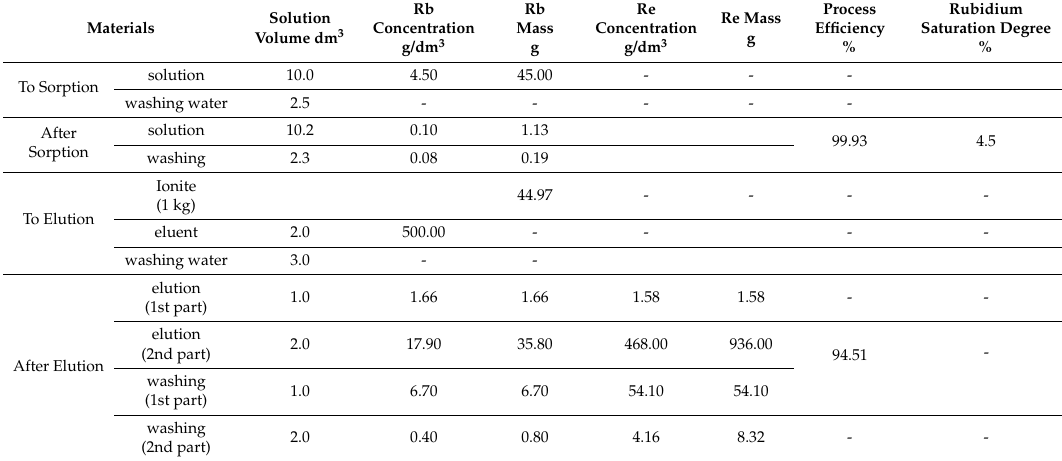
Table 13. Rubidium and rhenium sorption and elution mass balance—cycle I.